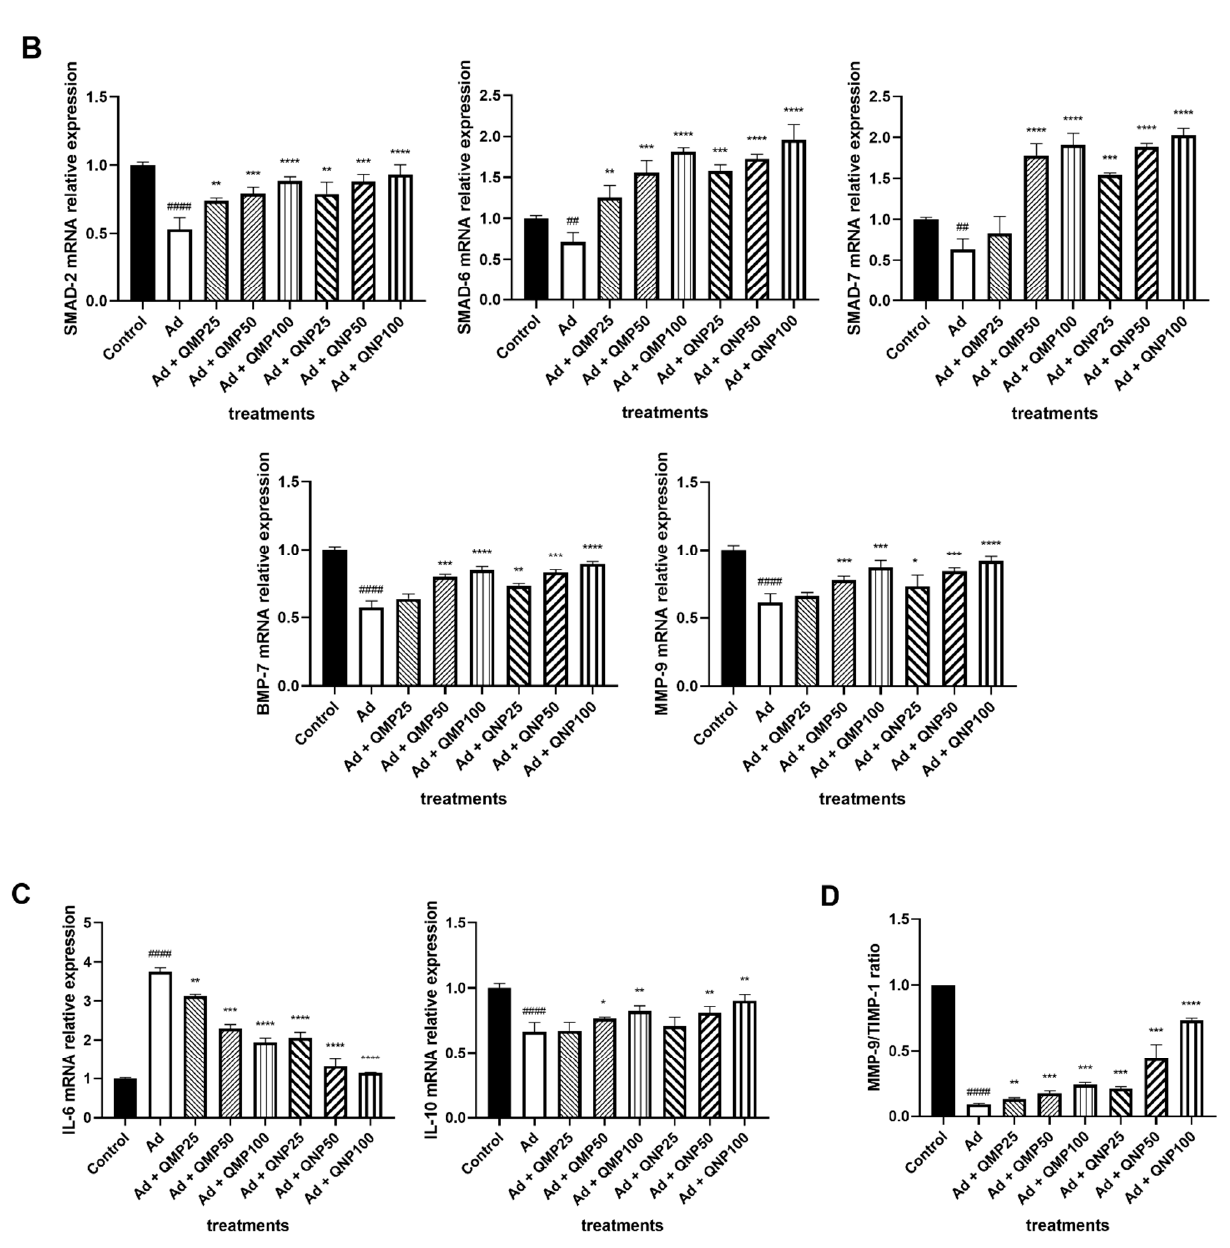
Figure 7. Effect of quercetin macroparticles and nanoparticles on the expression levels of profibro- genic, proinflammatory, antifibrogenic, and anti-inflammatory genes. Expression levels of key genes in the TGF- β /Smad and inflammatory signaling pathways were determined using RT-qPCR. QNPs diminished profibrogenic ( A ) and proinflammatory ( C ) gene expression and induced antifibrogenic ( B ) and anti-inflammatory ( C ) gene expression in a higher extent than QMPs. The MMP-9/TIMP-1 ratio ( D ) increased in the adenine group, while in the groups treated with both QMPs and QNPs, it decreased. Mean ± SD ( n = 5); ## p < 0.01, #### p < 0.0001 compared to the Control group; * p < 0.05, ** p < 0.01, *** p < 0.001, **** p < 0.0001 compared to the Ad group.